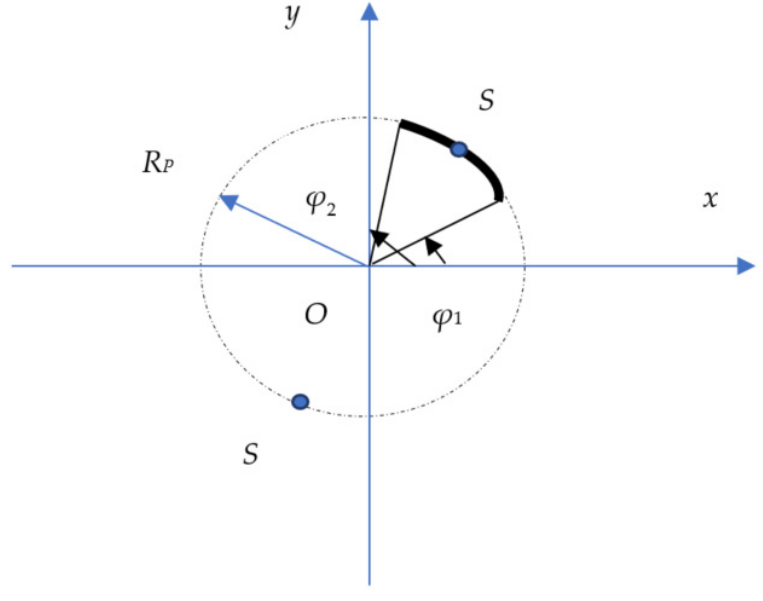
2 + y 2 = R 2 P S S